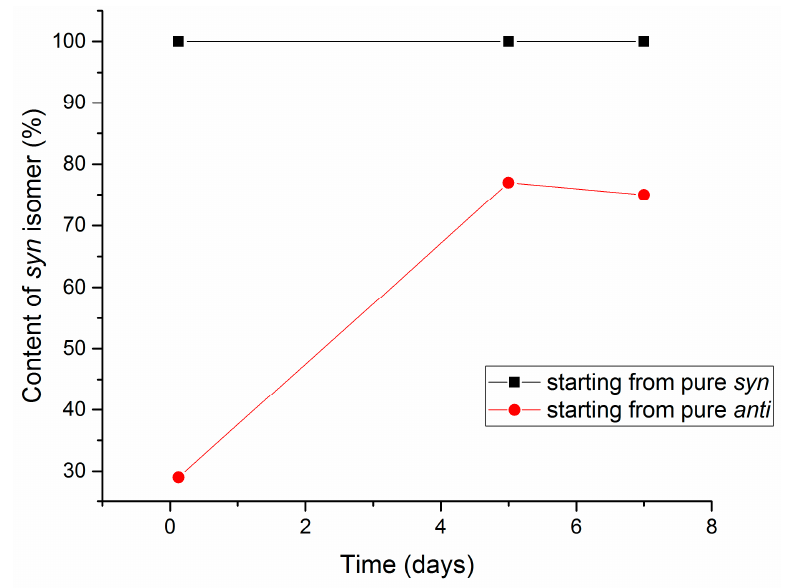
Figure 4. Amounts of syn oxime 1a after milling (Pulverisette 7 Premium Line mill, milling time 20 min) of the pure individual oxime isomers with 10 mol% p -TsOH during storage in solid state (the content was determined from 1 H-NMR spectra presented in the ESI—Figure S8).